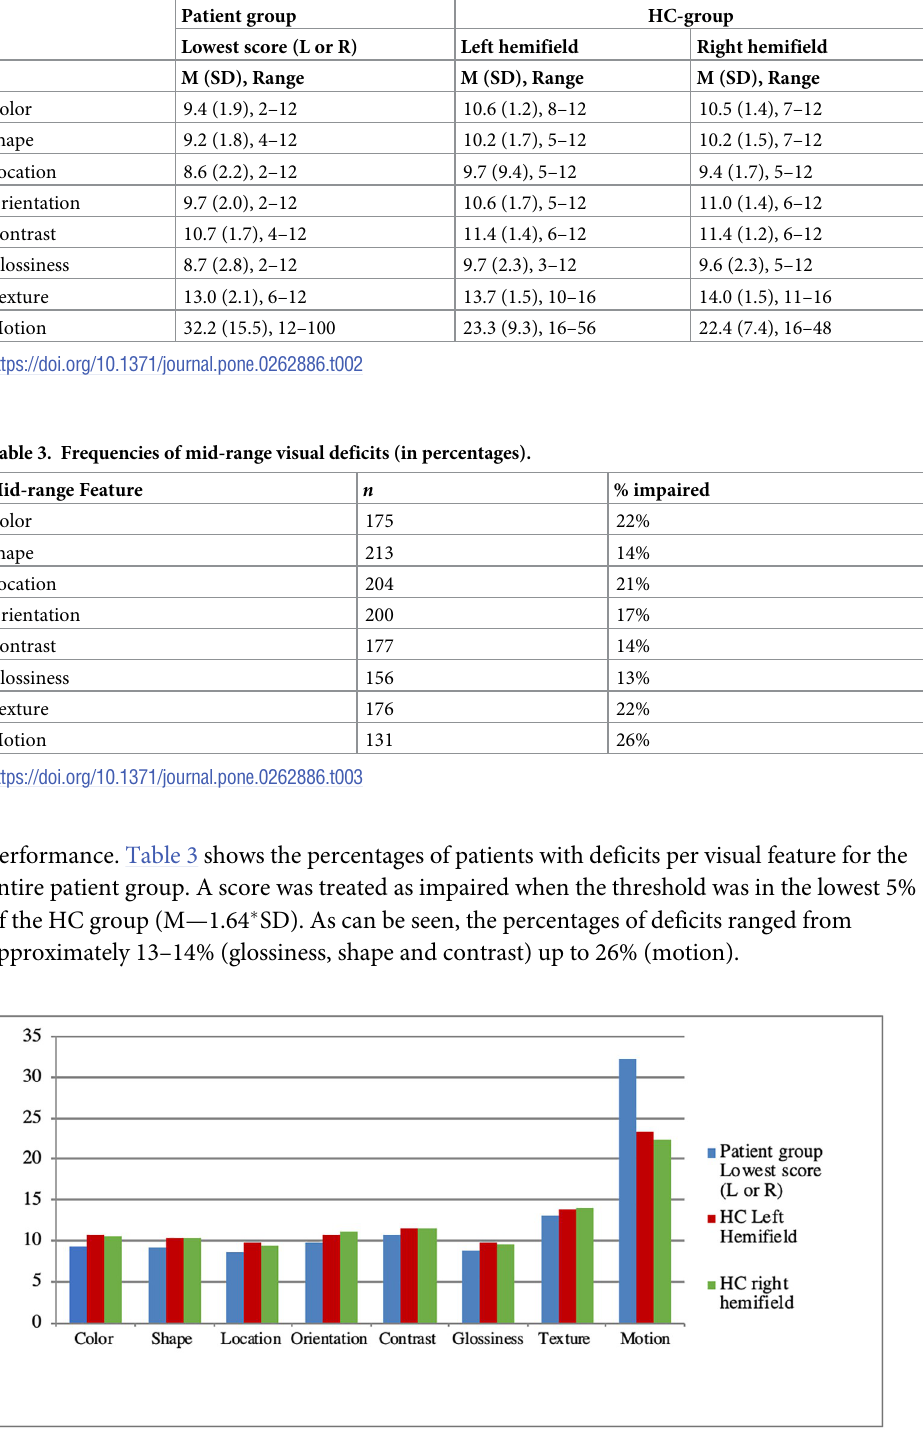
Fig 3. The mean scores for the patient group and the HC-group. For motion perception, lower scores indicate better performance. For all other tasks, higher scores indicate better performance.